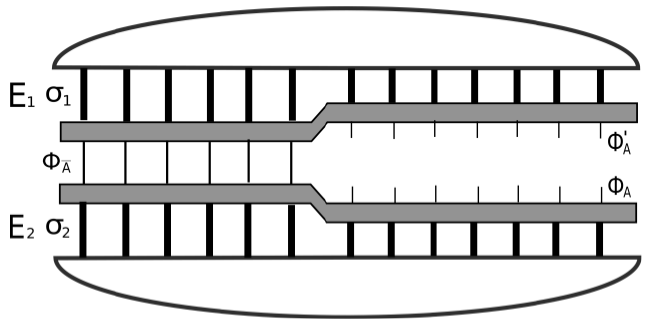
Figure 11 . A tensor representation of the density matrix of region A in